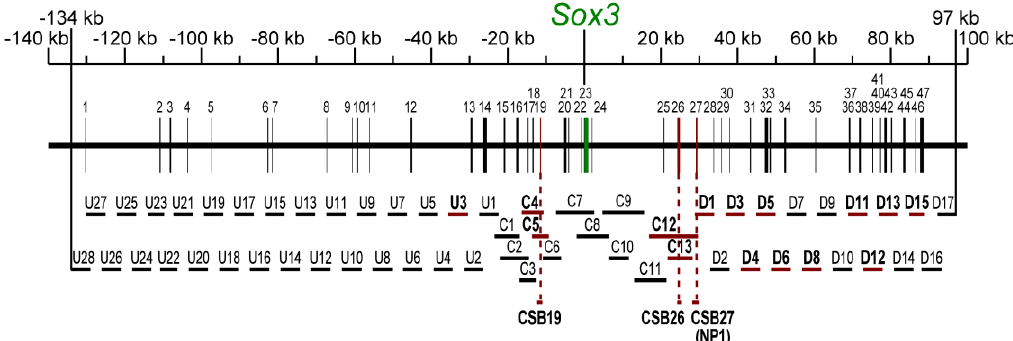
lens enhancer activity of C4/5. The CSB26 sequence included in the C12 sequence exhibited enhancer activity in the diencephalon and spinal cord, which was identical to the activity of the C12 sequence. Figure 2. DNA sequences derived from the Sox3 -encompassing genome region of the chicken and their analysis for enhancer activities. Distribution of CSBs 1-47 (black bars) upstream and downstream of the Sox3 gene. CSB23 includes the Sox3 open reading frame (ORF). The sequences of the central region, C1-C13, were derived from bacteriophage clones. The ~5 kb sequences that were upstream (U1 to U28) and downstream (D1 to D 17) with 1-kb terminal overlaps were derived from BAC clones. The DNA sequences indicated by red horizontal bars exhibited enhancer activity. CSBs 19, 26 and 27 that showed the same activity as the original DNA sequences are marked by red vertical bars. The nucleotide positions of these sequences and the statistics of the enhancer analysis are presented in Table S2.